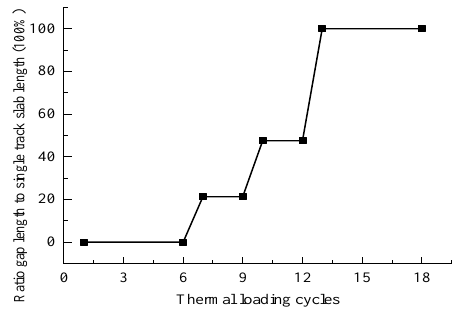
Figure 10. Curve of the gap length varying with the cycles of temperature loading action.